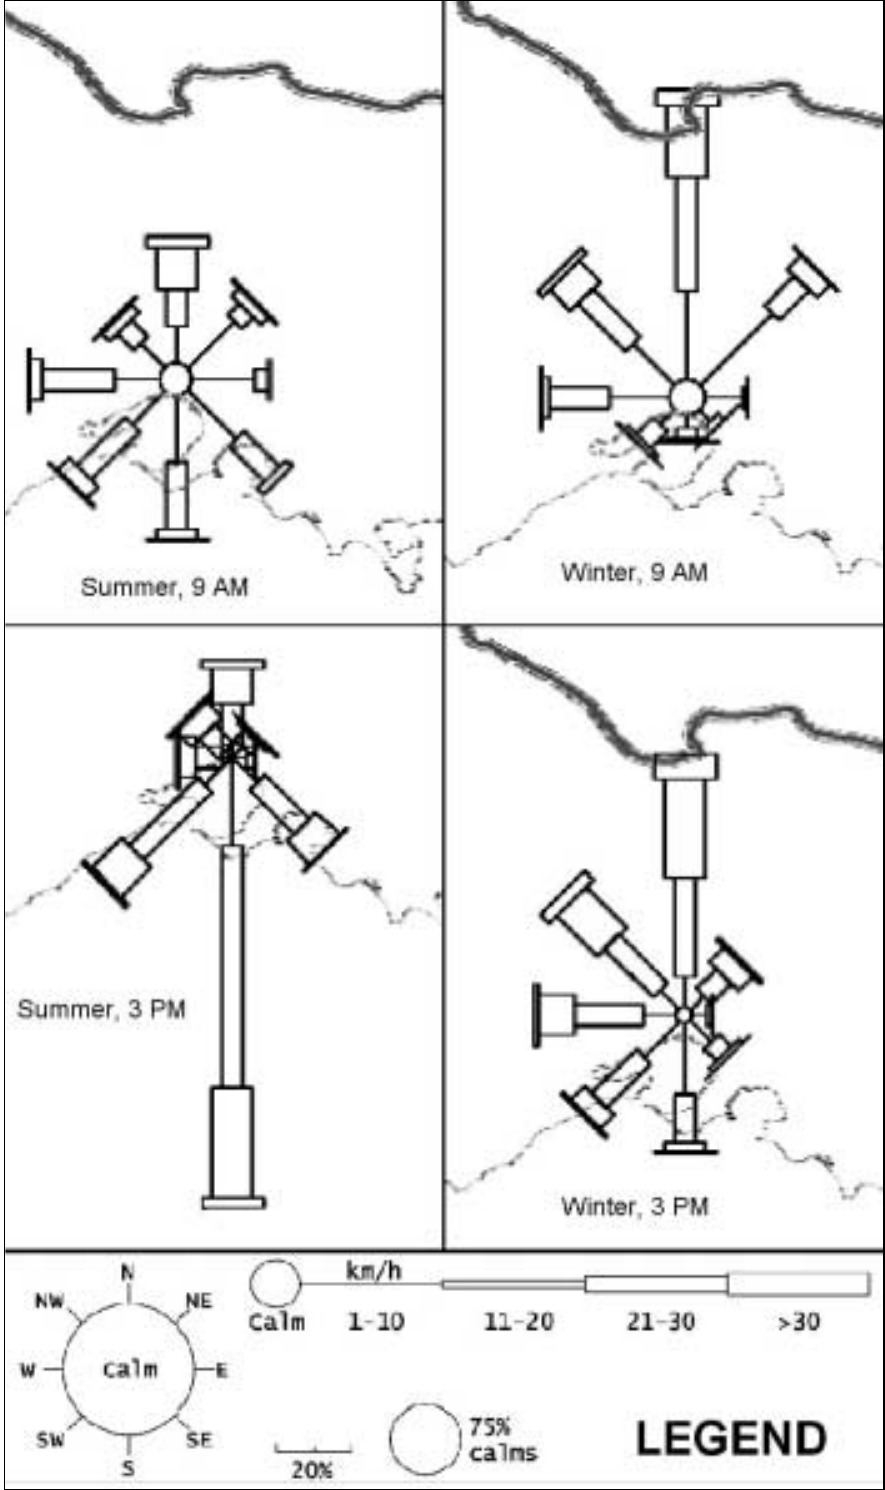
Figure 4. Summer and winter wind patterns for